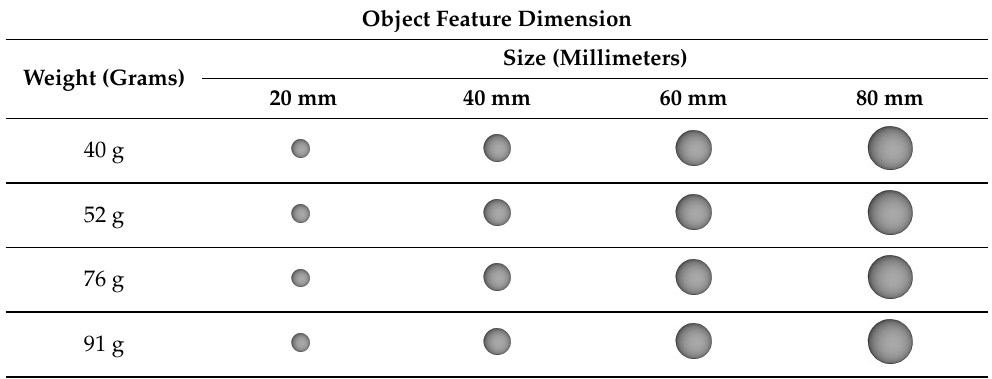
Table 1. Set of sphere objects that differed in size and weight. Each sphere was 3D-printed in different sizes. Lead balls were fixed in the center of the spheres to vary their weight. The complete set of spheres was used in all conditions of this